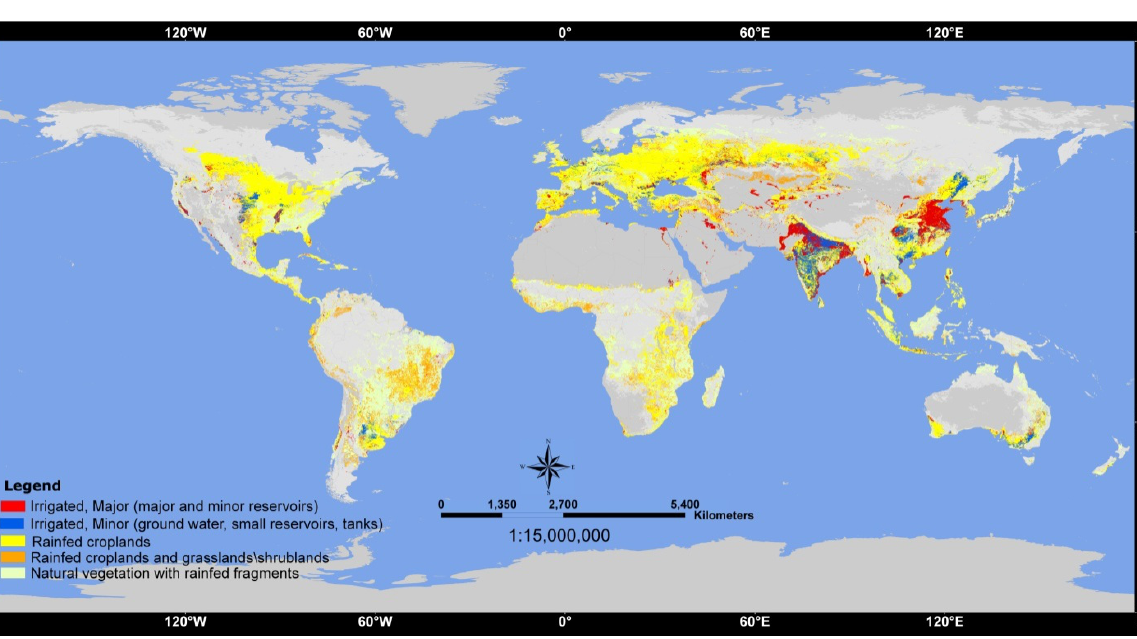
Figure 1. Global cropland map by Thenkabail et al . [1,2]. This includes irrigated and rainfed areas of the world as well as permanent crops. The product is derived using remotely sensed data. Total area of croplands is 1.53 billion hectares of which 399 million hectares is total area available for irrigation (without considering cropping intensity) and 467 million hectares is annualized irrigated areas (considering cropping intensity). The product is derived using 1–10 km base data. The output is given in nominal 1–km resolution. Also see: http://www.iwmigiam.org.